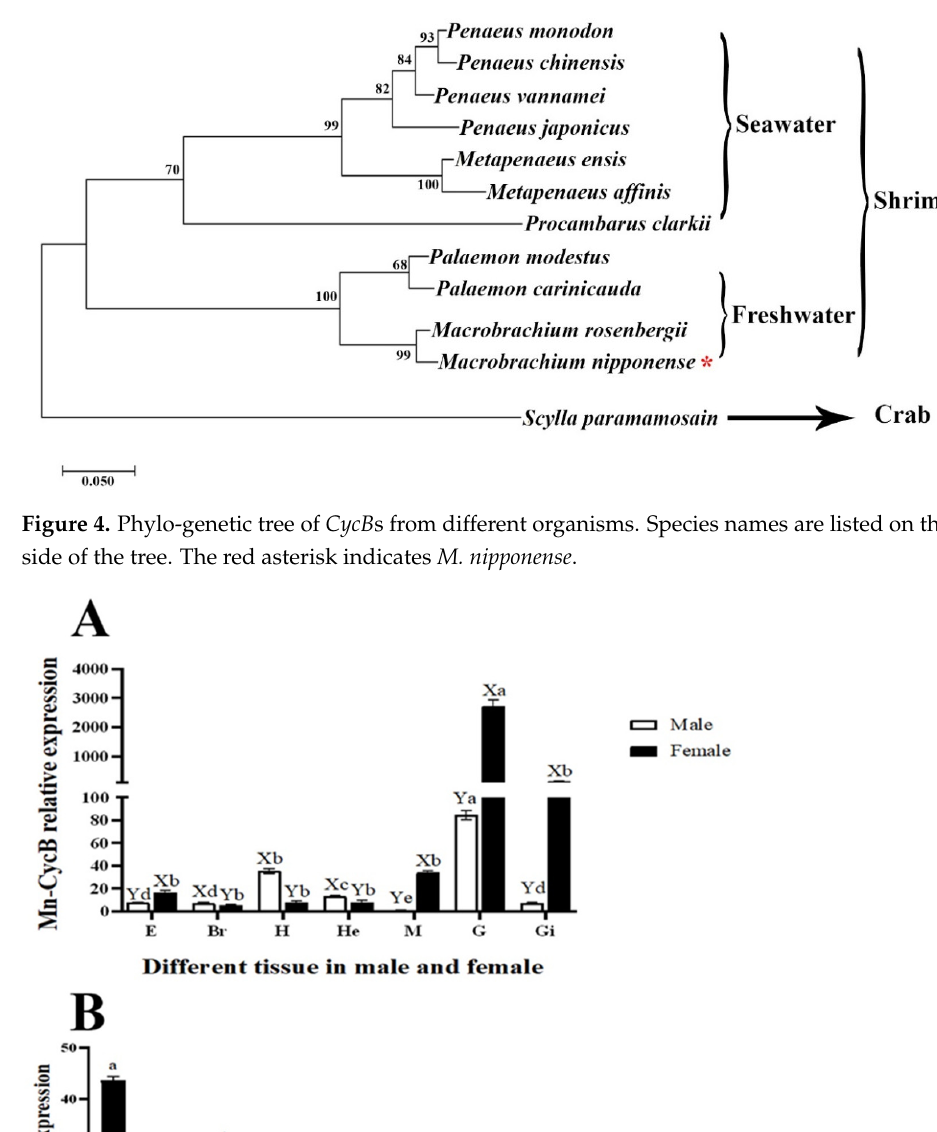
Figure 4. Phylo-genetic tree of CycB s from different organisms. Species names are listed on the right side of the tree. The red asterisk indicates M. nipponense .